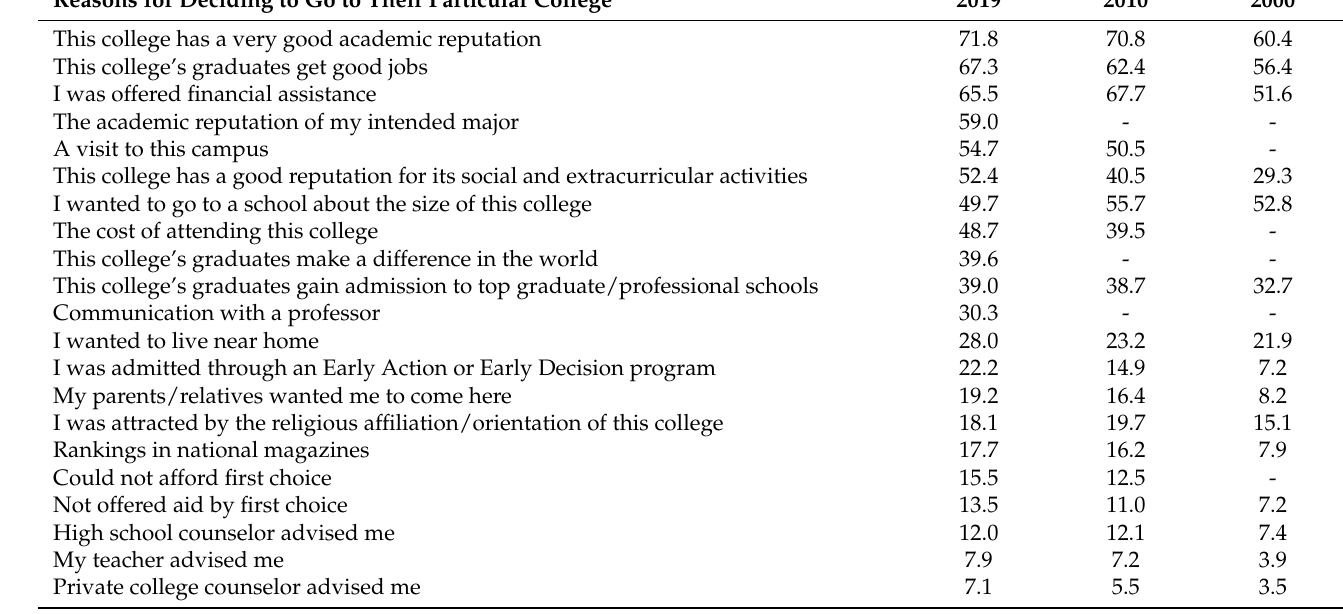
Table 5. Share of college freshmen declaring various reasons as “very important” in deciding to go